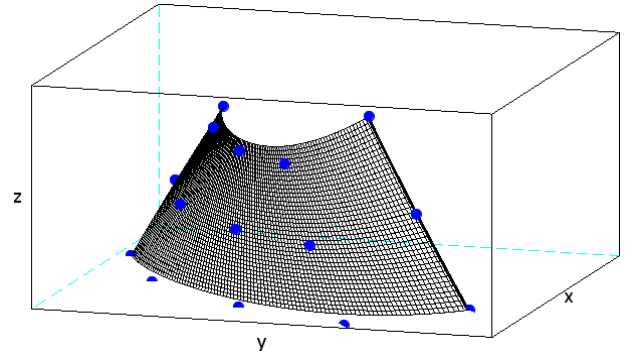
Figure 5. Control points and camber surface for the blade.